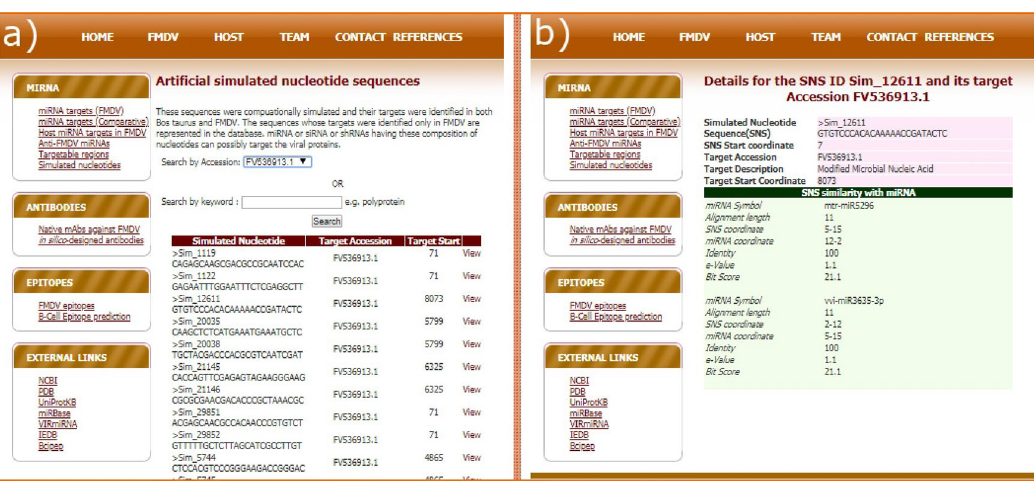
Figure 7. ( a ) Search interface and ( b ) result page of SNS targets in FMDV. The result page shows the SNS details, target details and the similarity of the SNS with miRBase